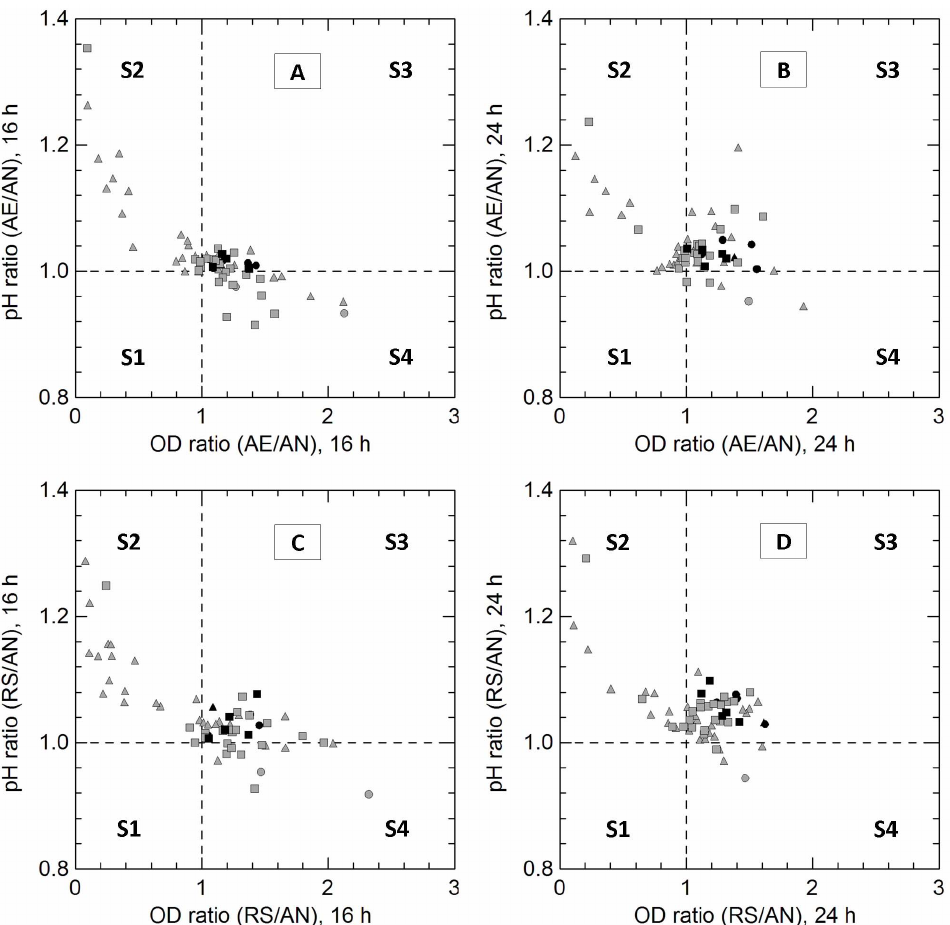
Figure 2. Distribution of L.casei (circles), L.paracasei (triangles) and L.rhamnosus (squares) strains on the basis of OD 650 nm (OD ratio AE/AN; OD ratio RS/AN) and pH (pH ratio AE/AN; pH ratio RS/AN) ratios. AN, anaerobiosis; AE, aerobiosis; RS, respiration. Graphs were divided in 4 sections by dashed lines to better represent the strains whose growth was stimulated (OD and pH ratios higher than 1) by aerobiosis (panel A and B , respectively at 16 and 24 h) or respiration (panel C and D, respectively at 16 and 24 h). Black symbols show the strains capable to consume oxygen (measurement with resazurin assay).